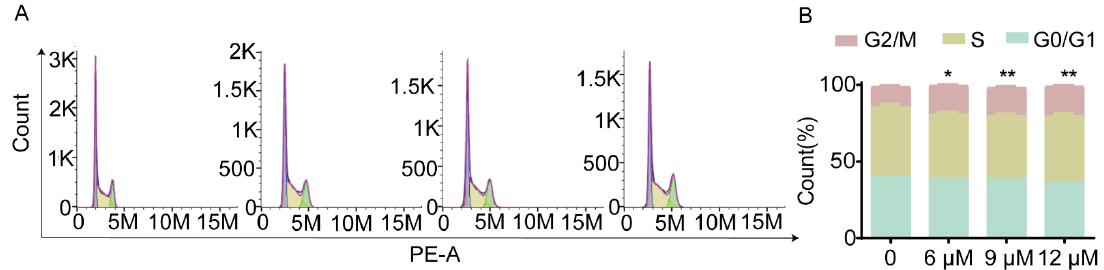
Figure 6. The compound 5c -induced HeLa cell G2/M phase arrest. ( A ) A comparison of the